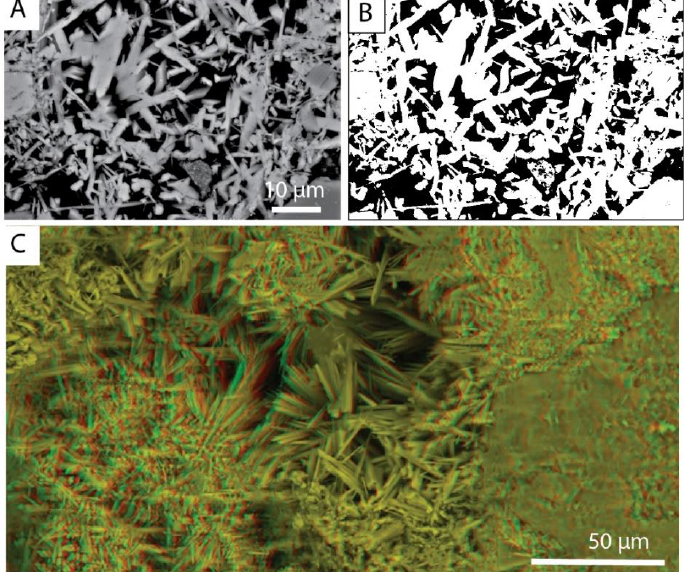
Figure 7. Illustration of complex pore morphology associated with acicular cements. ( A ) Scanning electron microscope (SEM) image, ( B ) binarised image of ( A ) for porosity (black), porosity = 62%, signifying that much of the pore space is open, but highly compartmentalised and baffled. Pores are difficult to model in terms of permeability using digital rock modelling (DRM) techniques, as they do not conform to the standard spherical pore models commonly used. ( C ) Three-dimensional stereo image, illustrating the complexity of pore spaces in three dimensions (requires green-red stereo glasses).